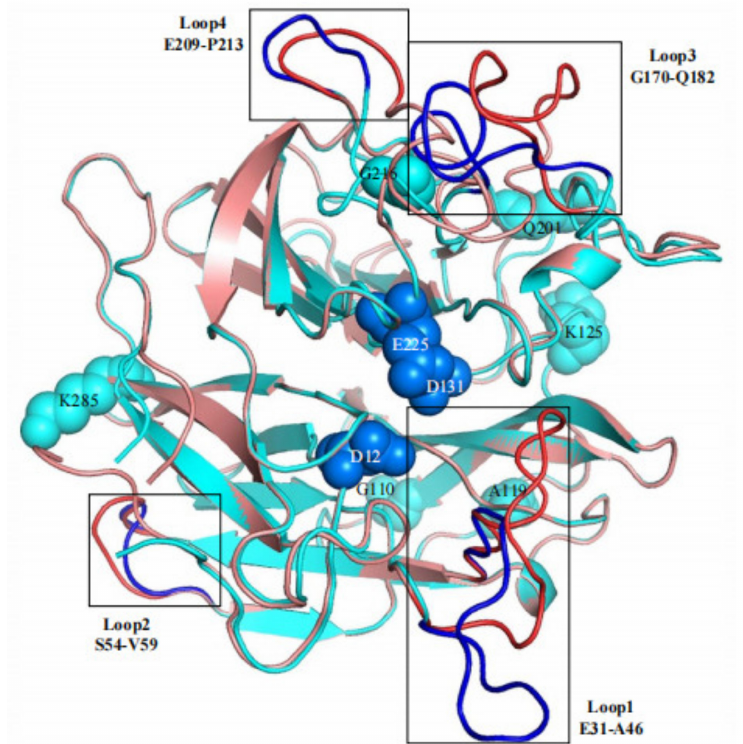
Figure 6. The comparison of protein structures between xylosidase AX543 (blue) and the xylosidase Xyl43A (red). Three conserved catalytic residues of AX543 (Asp12, Asp131, and Glu225) are marked in navy blue, and the single mutation site is displayed in light blue. The mutation loop regions are shown by deep color and marked with a